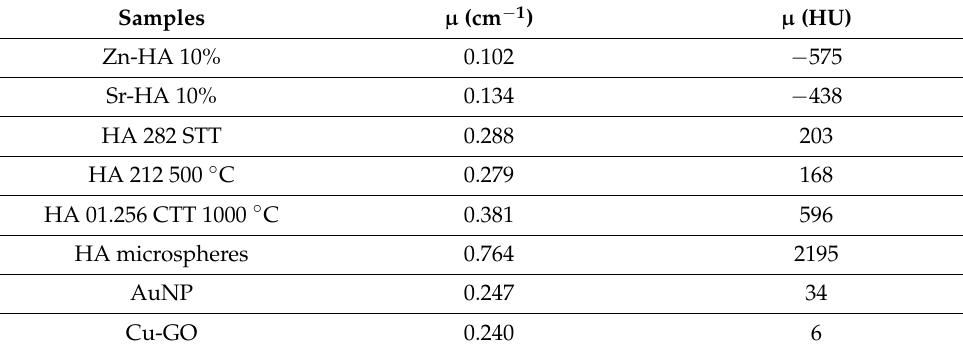
Table 1. Results of the X-ray attenuation coefficient ( µ ) expressed in cm − 1 and Hounsfield units for Zn-HA 10% (1), Sr-HA 10% (2), HA 282 STT (3), HA 212 500 ◦ C (4), HA 01.256 CTT 1000 ◦ C (5), HA microspheres (6), AuNP (7), and Cu-GO (8) samples. Samples µ (cm − 1